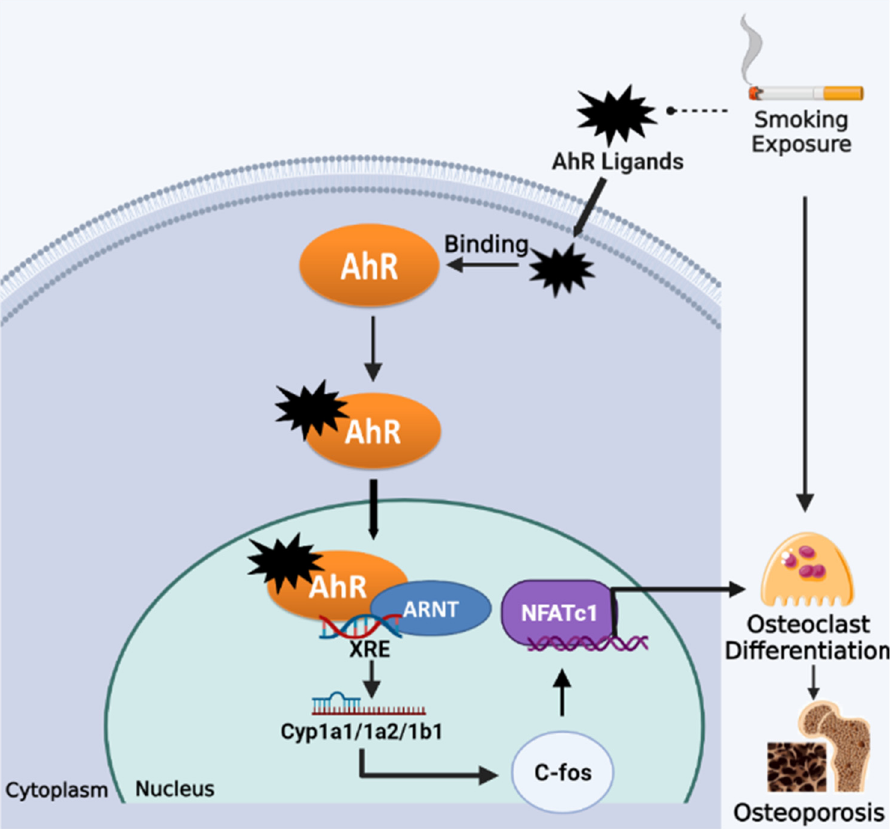
Figure 3. Smoking exposure induces osteoclast differentiation through the AhR pathway, leading to osteoporosis. Dotted lines represent release, arrows represent promotion.